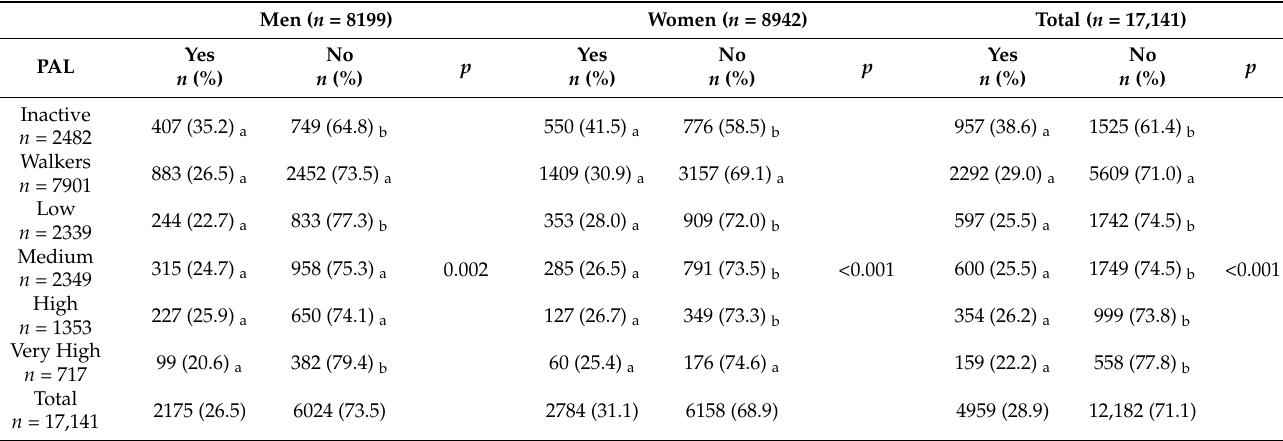
Table 6. Associations between the use of emergency services and physical activity level in the general Spanish population aged 18–69 years compared by sex, according to the ENSE 2017. Men ( n =